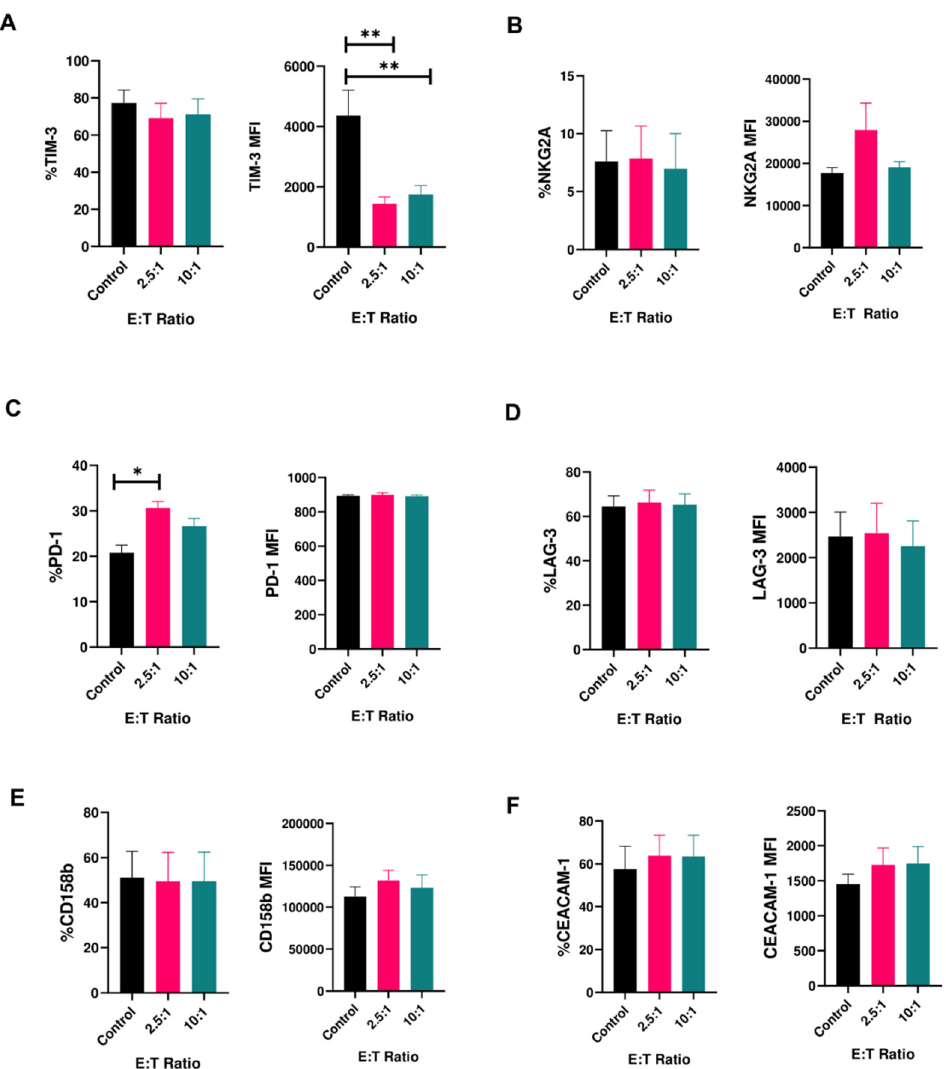
Figure 1. Expression of inhibitory receptors on human NK cells in response to cancer cells (mean ± SEM). Percentage ( left panels ) and median fluorescence intensity (MFI) ( right panels ) of ( A ) T-cell immunoglobulin and mucin-containing domain (TIM-3); ( B ) NGK2A; ( C ) PD-1; ( D ) LAG-3; ( E ) CD158b; ( F ) CEACAM-1 on peripheral blood-derived human NK cells upon co-culture with U87MG cells for 4 h at e ff ector:target (E:T) ratios of 2.5:1 and 10:1 ( n = 6–9 samples). * p < 0.05, ** p < 0.01.